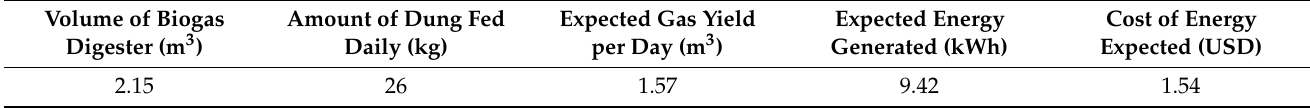
Table 3. Energy cost, yield, and rate of the feeding of the biogas